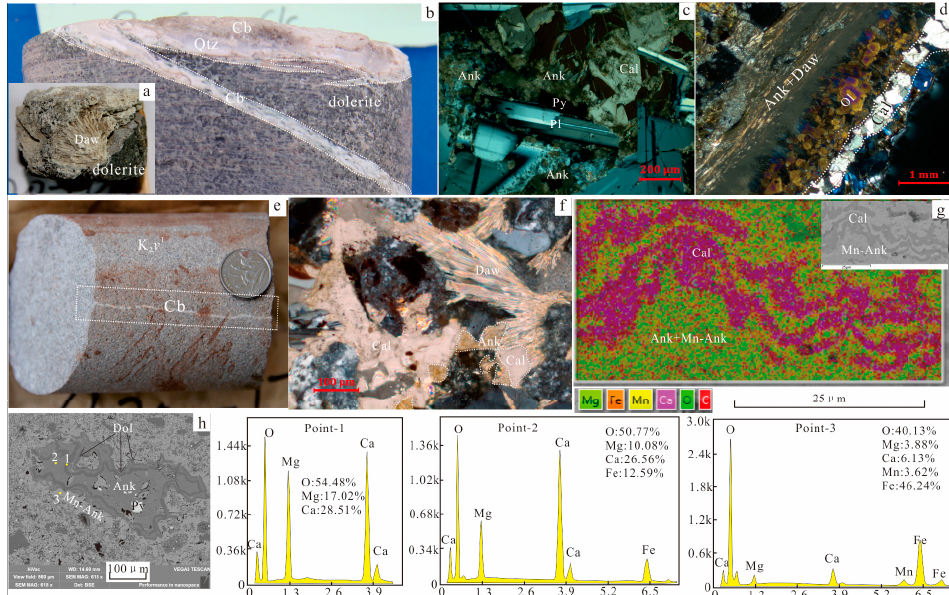
Figure 3. Macro-micrographs and energy spectra of dolerite and hydrothermal carbonate in the lower member of Yaojia Formation in Qianjiadian ore field. ( a ) Dolerite with radial dawsonite, ( b ) Dolerite bearing quartz and carbonate veins, ( c ) Dolerite with produces of pyrite, calcite and ankerite, ( d ) Dolerite with different types of carbonate veins, ( e ) Gray dense sandstone with late carbonate veinlets, ( f – h ) Progressive evolution of different carbonate minerals. Daw: dawsonite; Cb: carbonate; Qtz: quartz; Ank: ankerite; Cal: Calcite, Ol: olivine; Py: pyrite; Pl: plagioclase, Mn-Ank: ferromanganese dolomite; Dol: dolomite.